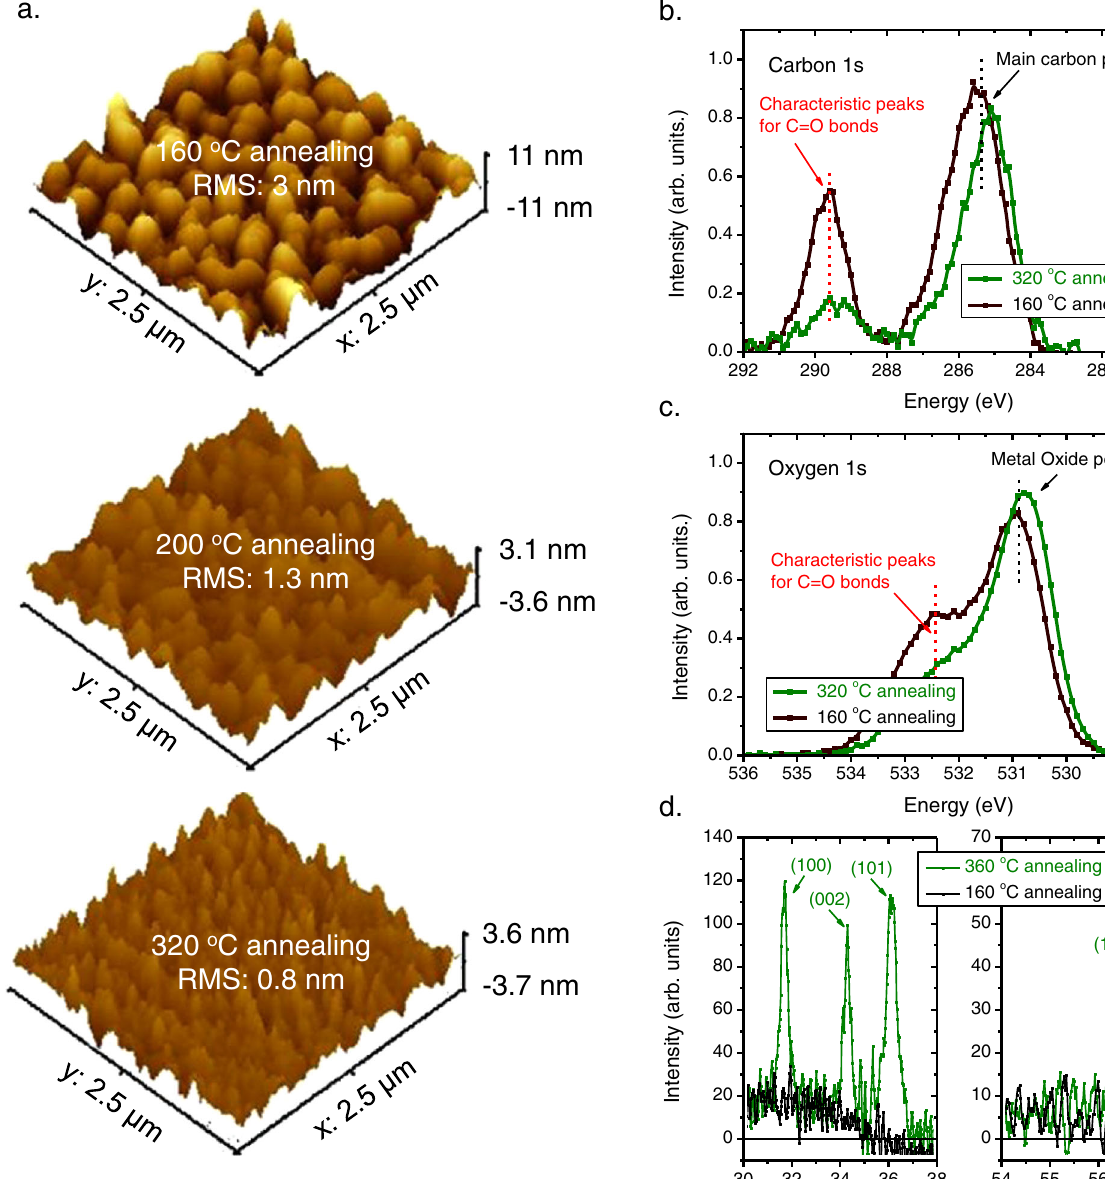
the ZnO fi lm annealed at different temperatures. d XRD spectra of